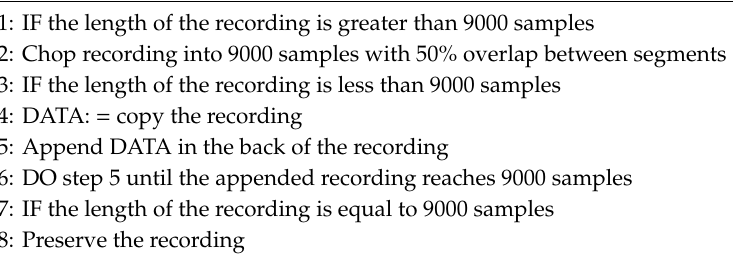
Algorithm 1. Pseudocode of data length normalization.